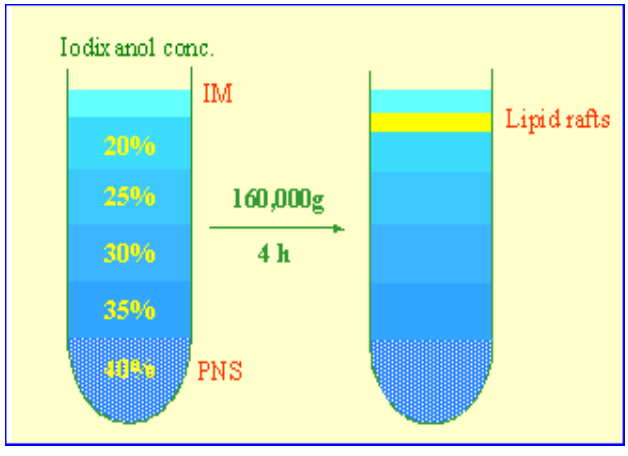
FIGURE 1 . Isolation of lipid rafts by flotation from a postnuclear supernatant (PNS) in a discontinuous iodixanol gradient. IM = Isolation Medium. See text for more details.